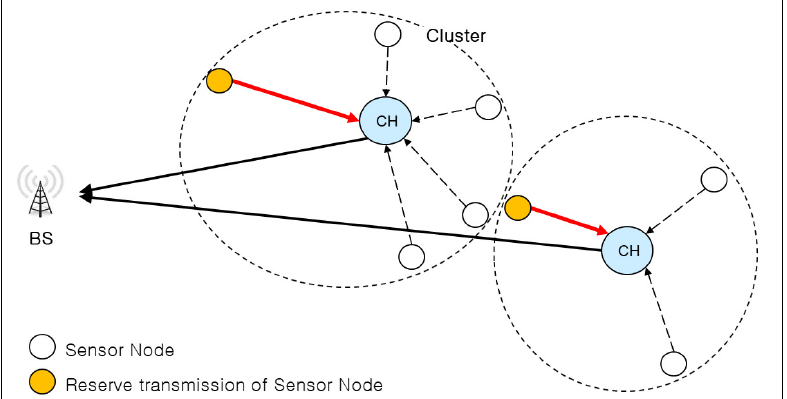
Figure 2. Reverse transmission of sensor